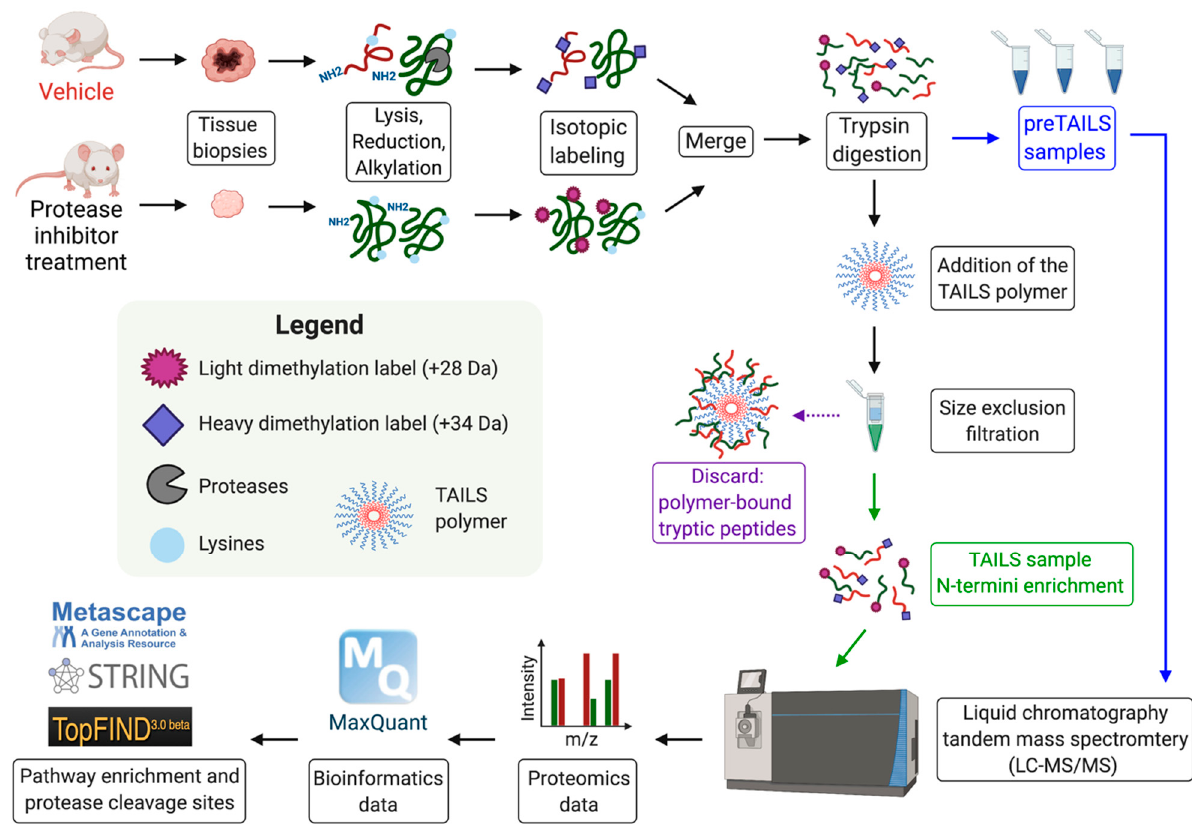
Figure 2. Experimental workflow of the N-terminomics/TAILS protocol using dimethylation isotopic labeling in a cancer mouse model treated with a protease inhibitor or a vehicle control. Tumors are lysed, reduced and alkylated before being isotopically labeled with light (+28 Da) or deuterated (+34 Da) formaldehyde. Proteins are then digested with trypsin and a pre-enrichment TAILS sample is collected. The remaining peptides are subjected to the TAILS polymer and N-termini are added to a size exclusion filter. Samples are subjected to liquid chromatography and tandem mass spectrometry (LC-MS/MS). The proteomics data is analyzed by bioinformatics software (e.g., MaxQuant). Data interpretation is analyzed with pathway enrichment tools (Metascape, STRING) or protease analysis software (TopFIND).